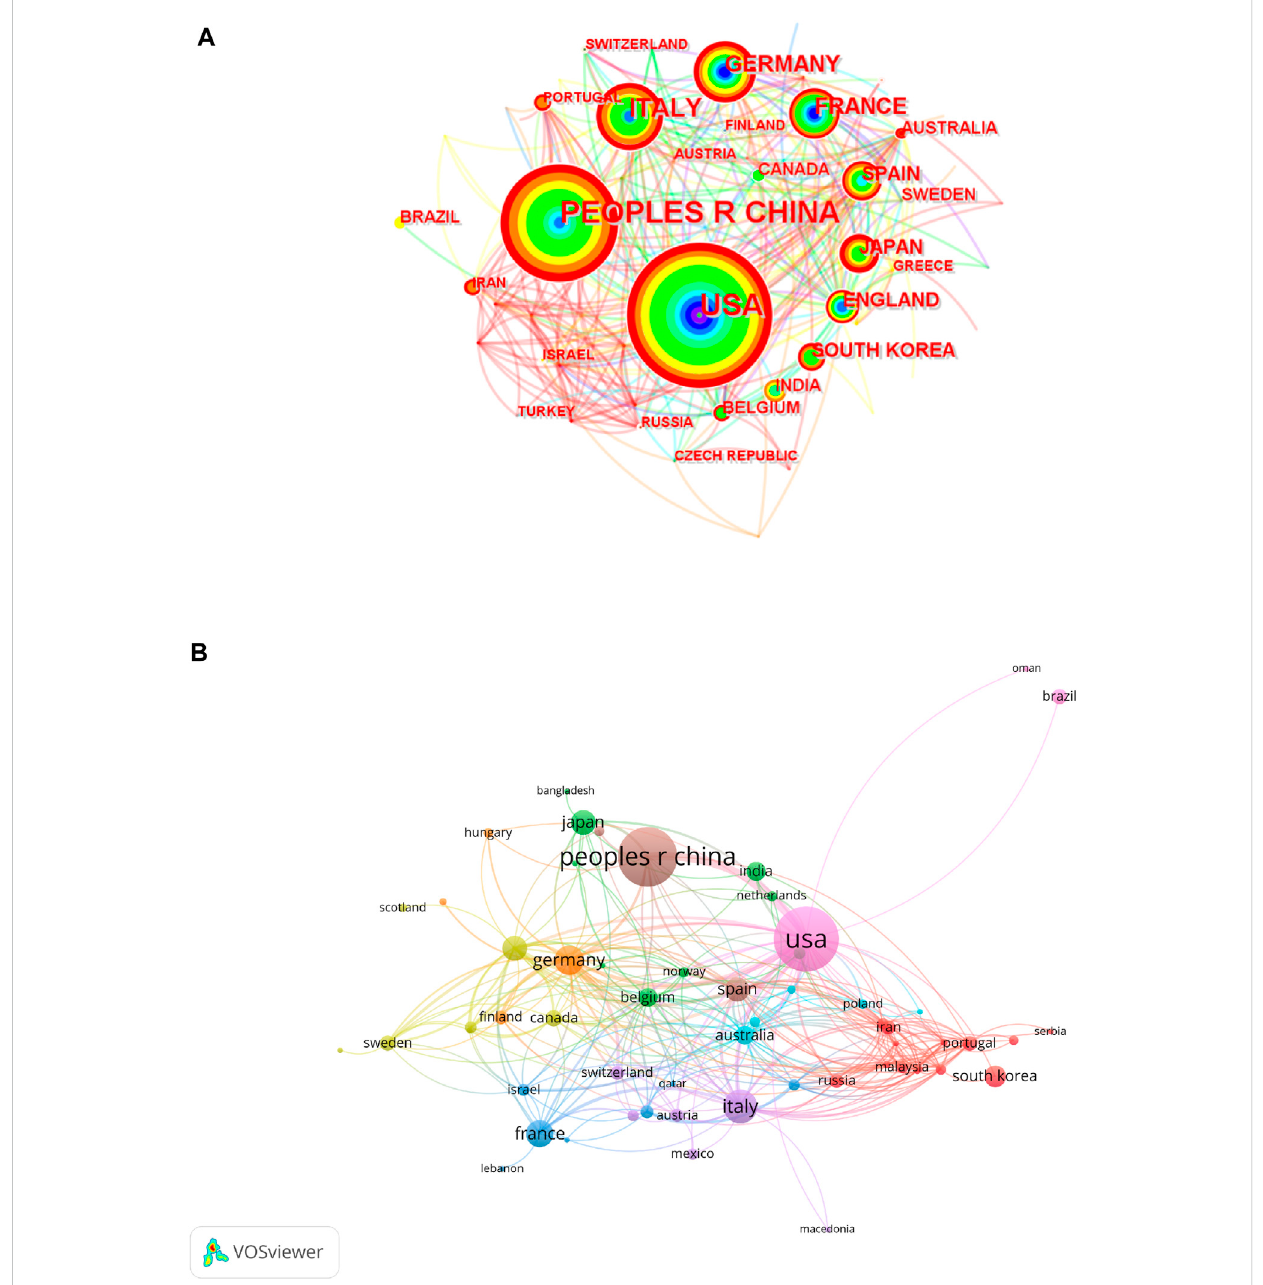
Production and cooperation map of the country. (A) Network map of national publication volume and cooperation between countries. (B) Co- authorship network map of